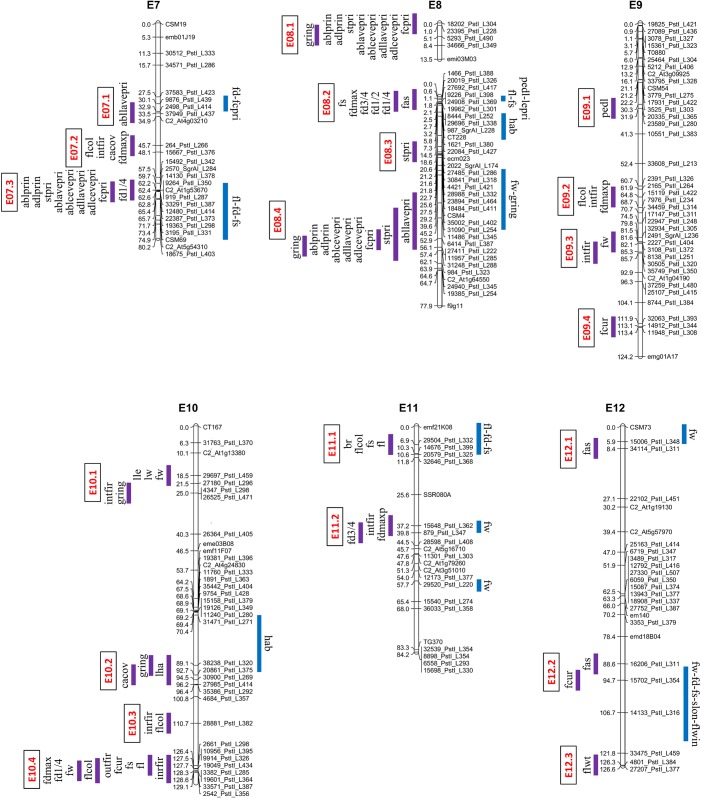
Regions identified by GWA in eggplant LG E07-E12 in comparison to QTL locations described by Portis et al. [2].The GWA outcome is given to the left of each chromosome (the vertical bars represent a ±3.4 cM interval around the position of the associated SNP loci) and the various regions are marked in red. The QTL locations are shown to the right of each chromosome.